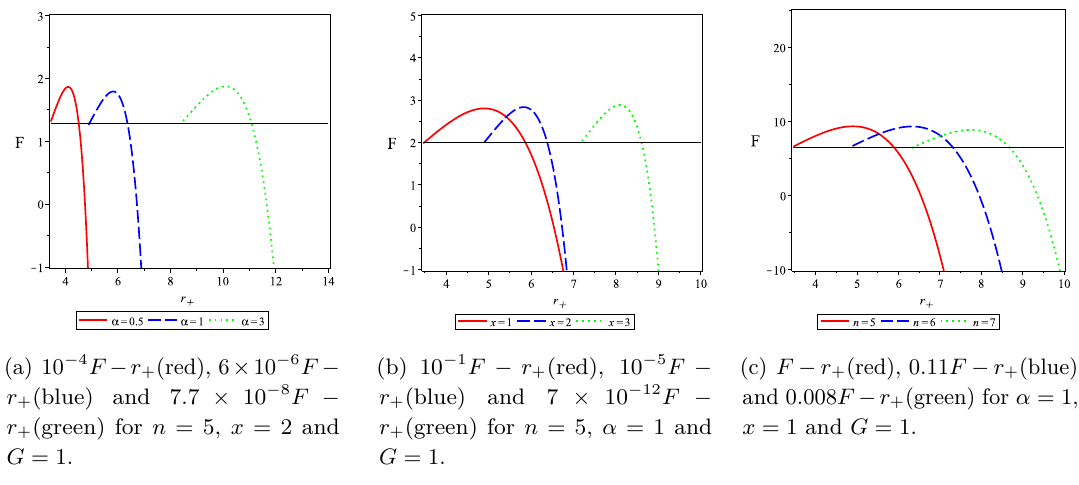
Figure 4 . Behavior of the free energy versus r + for k = − 1 for “ − ” sign branch.